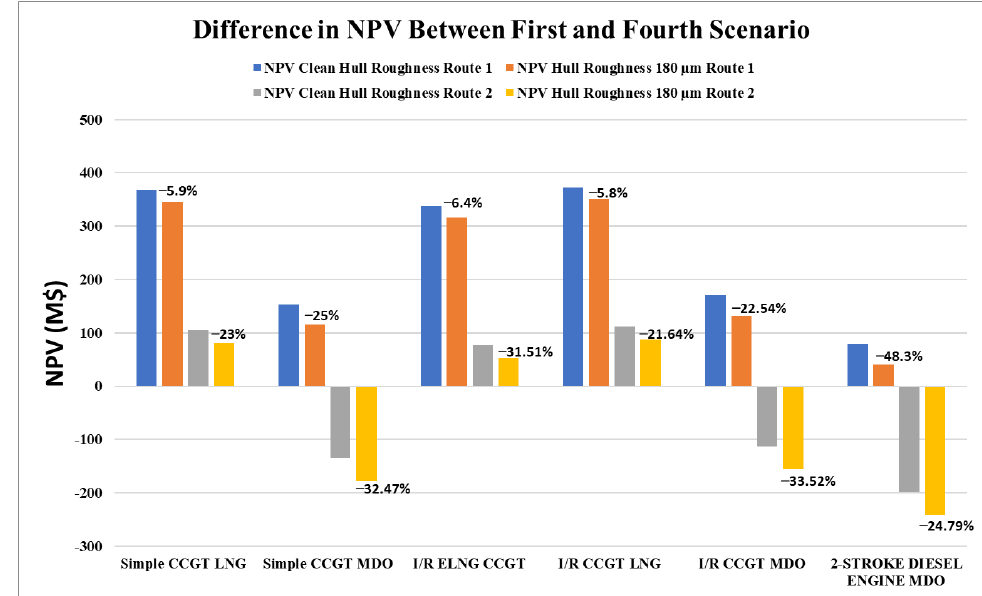
Figure 10. Difference in NPV between the first and fourth scenarios for Routes 1 and 2.